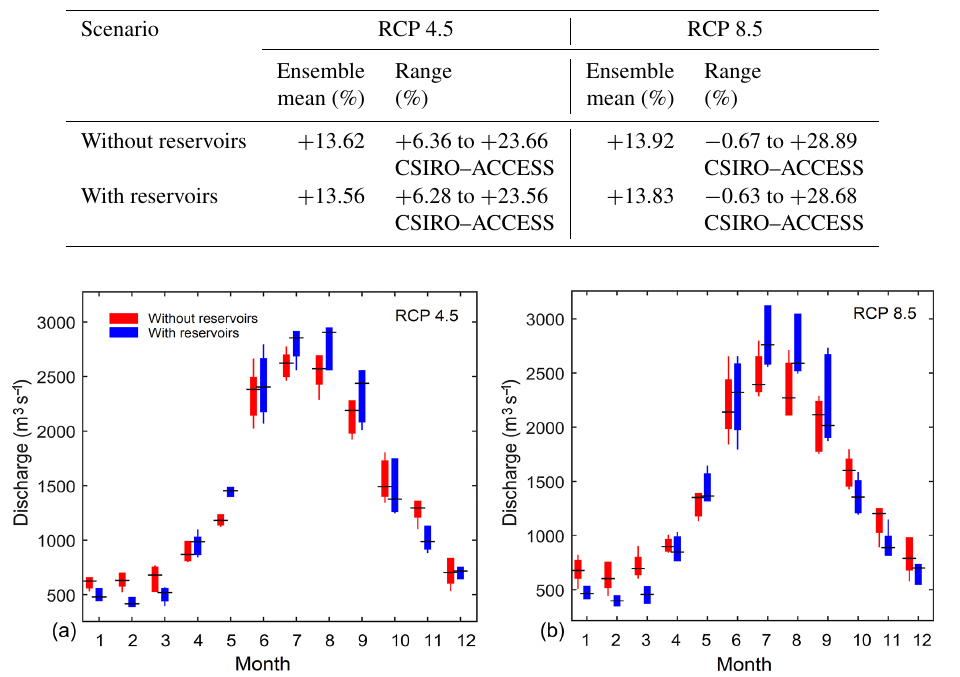
Figure 11. Variability in monthly discharges at Jiuzhou station predicted by the two selected models (with and without reservoirs) under RCP 4.5 (a) and RCP 8.5 (b)